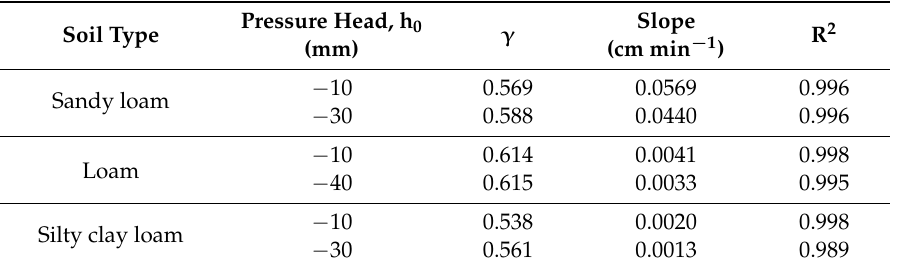
Table 3. Estimated shape parameter γ from the slope of the fitted linear function I 3D − I 1D (t) on the experimental data using Equation (1). R 2 is the coefficient of determination between the experimental I 3D − I 1D (t) data and fitted curve for γ